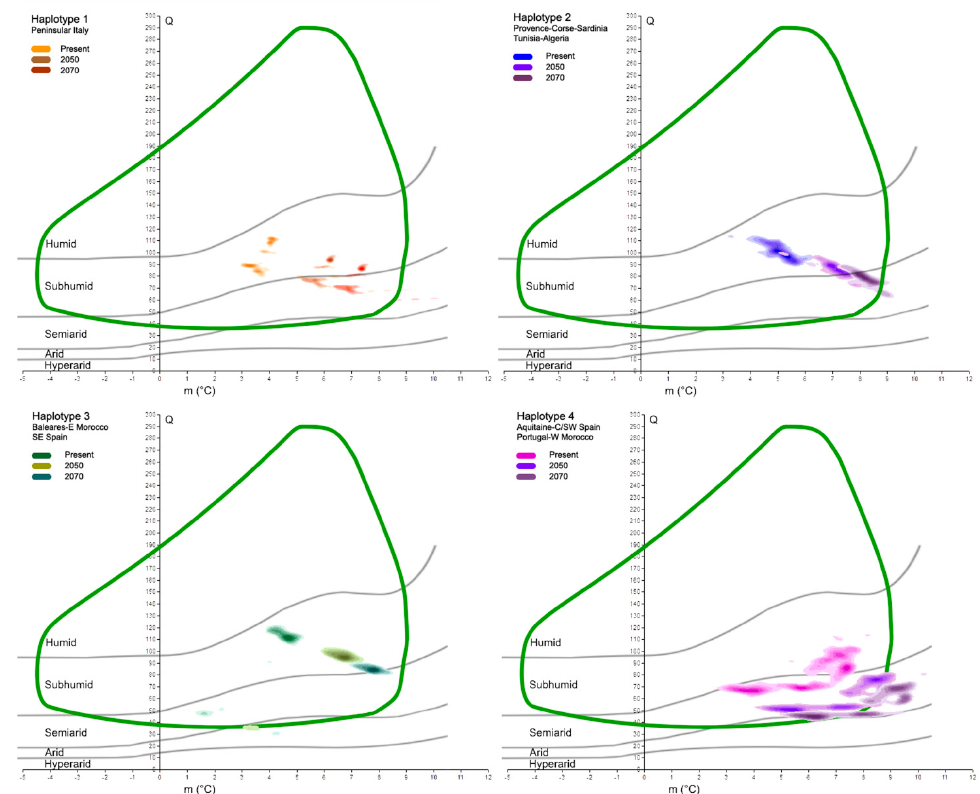
Figure 6. Projections of results shown in Figure 5 to 2050 and 2070 time slices. Each box shows the comparison of a haplotype at present and in the future. Cork oak climatogram (green curve) is used as reference. Table 2. Minimum, mean and maximum values of Q and m parameters for the haplotypes investi- gated in this study. Present, 2050 and 2070 time slices are reported for comparison. Orange Blue Green Purple